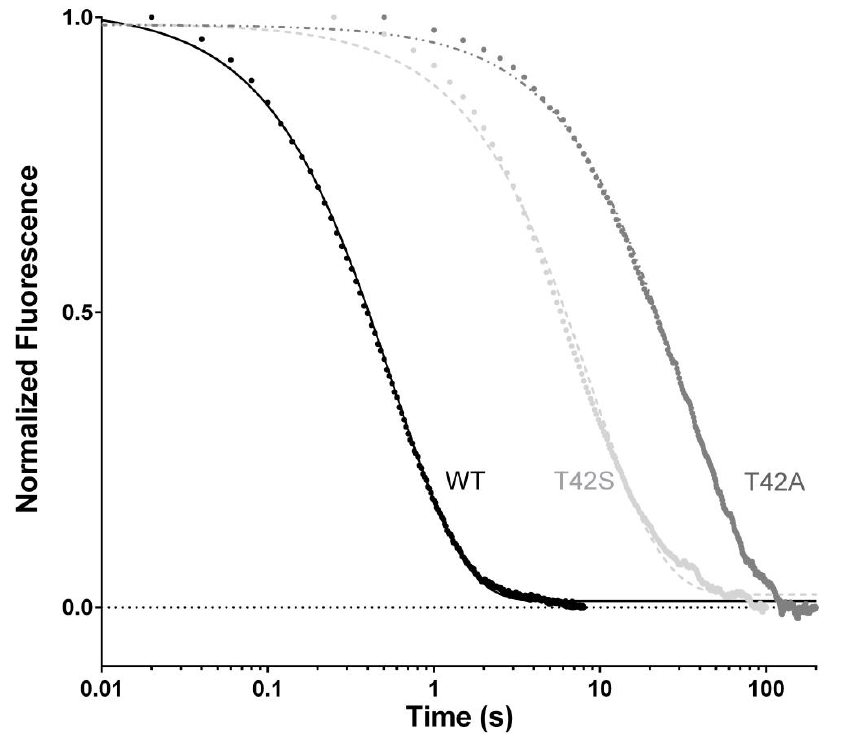
Figure 2. Displacement of the complex N-SH2:dansyl-Gab2 608 − 620 by a large excess of non-dansylated Gab2 608 − 620 . Lines represent the best fit to a single exponential equation.